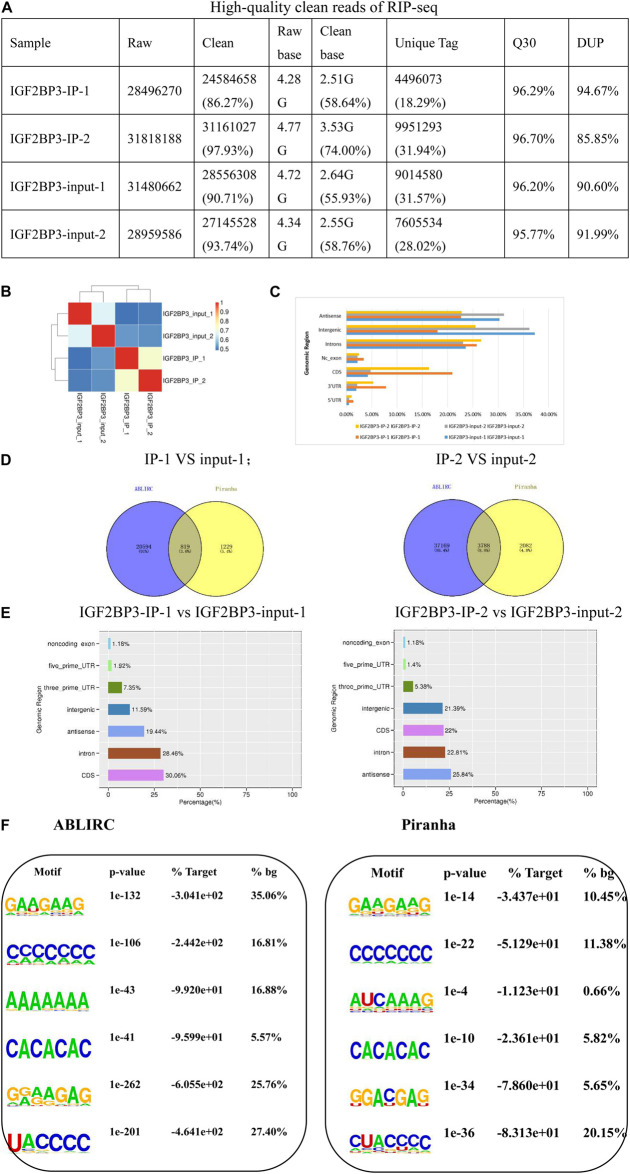
IGF2BP3 strongly associates with mRNAs more at CDS regions than at 3′UTRs. (A) The form shows the quality control of our iRIP-sequence is good. (1) Raw data: the number of original sequences transformed from the original image data obtained by sequencing through base calling; (2) Clean reads: the raw reads are stripped of the adapter sequence, and the number of valid sequences obtained after low-quality bases is used for subsequent analysis; (3) Raw base: the count the number of bases it contains, based on the number and length of raw reads, in G; (4) Clean base: according to the number and length of clean reads, count the number of bases it contains, in G; (5) Unique tag: unique tag, the number of non-repeating reads and its proportion of clean reads; (6) Q30: Proportion of bases whose sequencing error rate is less than 0.1%; (7) DUP: duplication level. The ratio of duplicate reads to total reads. (B) Heat map showing the hierarchically clustered Pearson correlation matrix resulting from comparing the transcript expression values for control and IGF2BP3 IP samples. (C) Bar plot of the genomic region distribution of the control and uniquely mapped IGF2BP3 IP reads. (D) The peak distribution across reference genomic region of the IGF2BP3 IP and control group. (E) Venn diagram analysis from the comparative result of ABLIRC and Piranha peak calling methods. (F) Extracted IGF2BP3 peaks motifs using ABLIRC or Piranha.